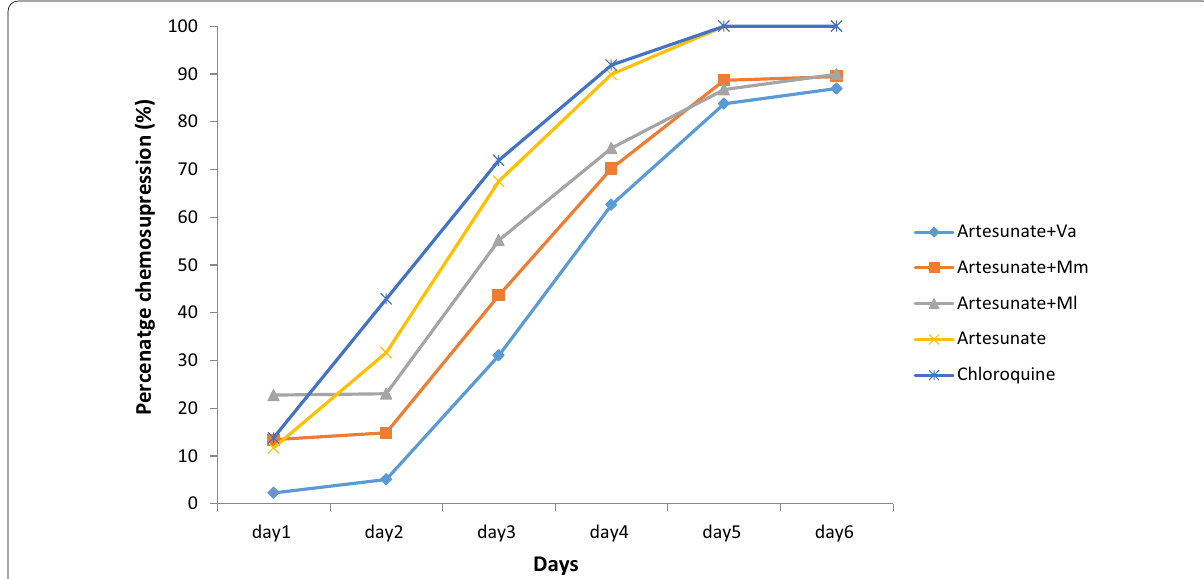
Fig. 2 Percentage chemosuppression of parasitaemia of infected mice treated with combined